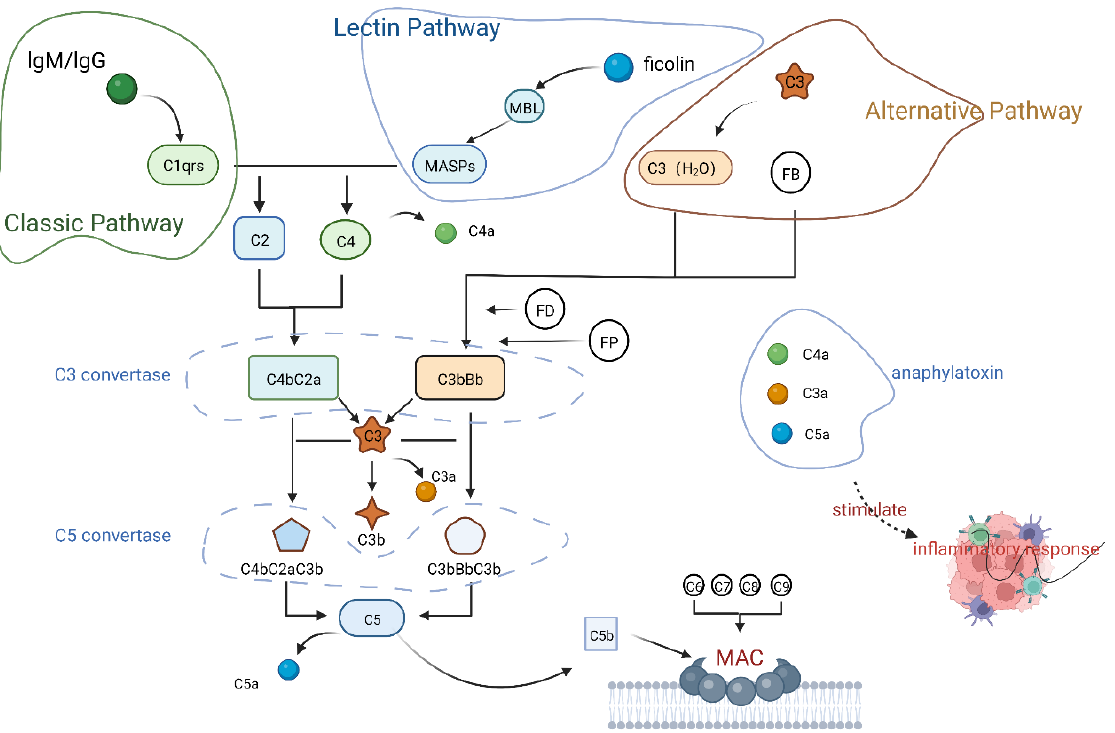
Figure 1. Complement system activation pathways. Created with BioRender.com (accessed on 13 June 2022).